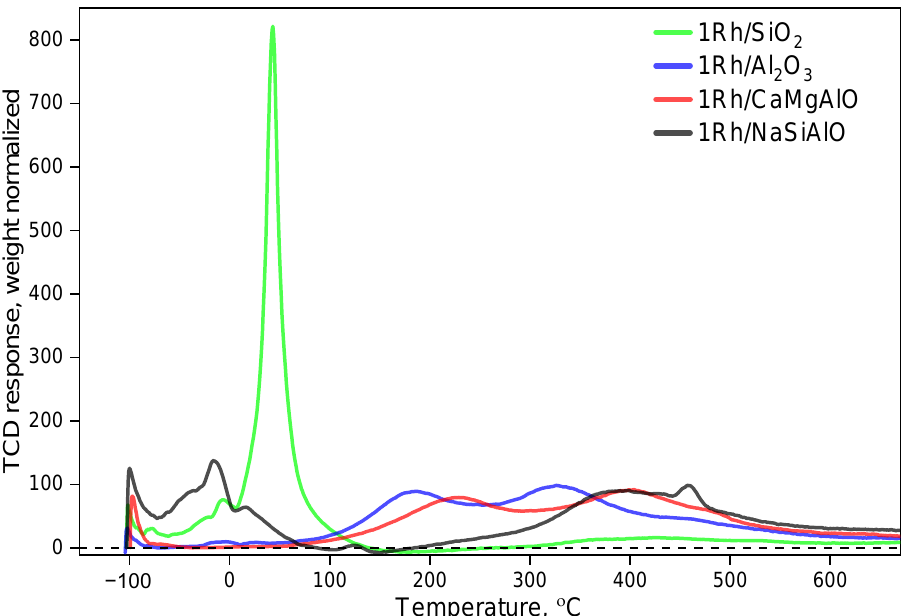
Figure 11. TPR-H 2 profiles for the rhodium-loaded catalysts.